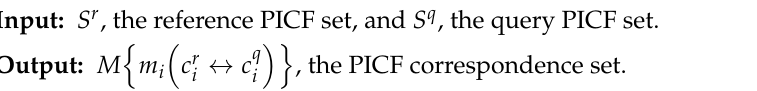
Algorithm 1 PICF matching